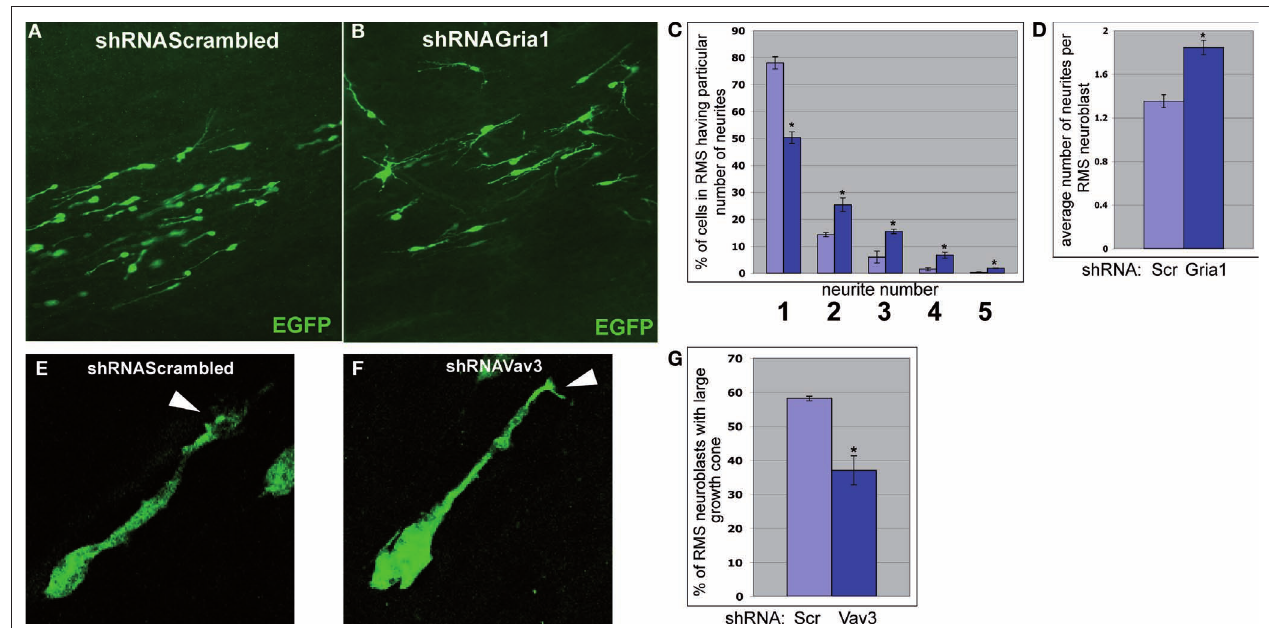
FIGURE 8 | Effects of Gria1 or Vav3 knockdown on the shape of migrating neuroblasts. (A) and (B) Neuroblasts migrating in anterior RMS subsequent to infection with shRNAScrambled and shRNAGria1 expressing viruses, respectively. (C) Gria1 knockdown resulted in a decrease of neuroblasts having one neurite and an increase of neuroblasts having two and more neurites (light blue – control, dark blue – Gria1 knockdown) (* p < 0.005). (D) Gria1 knockdown